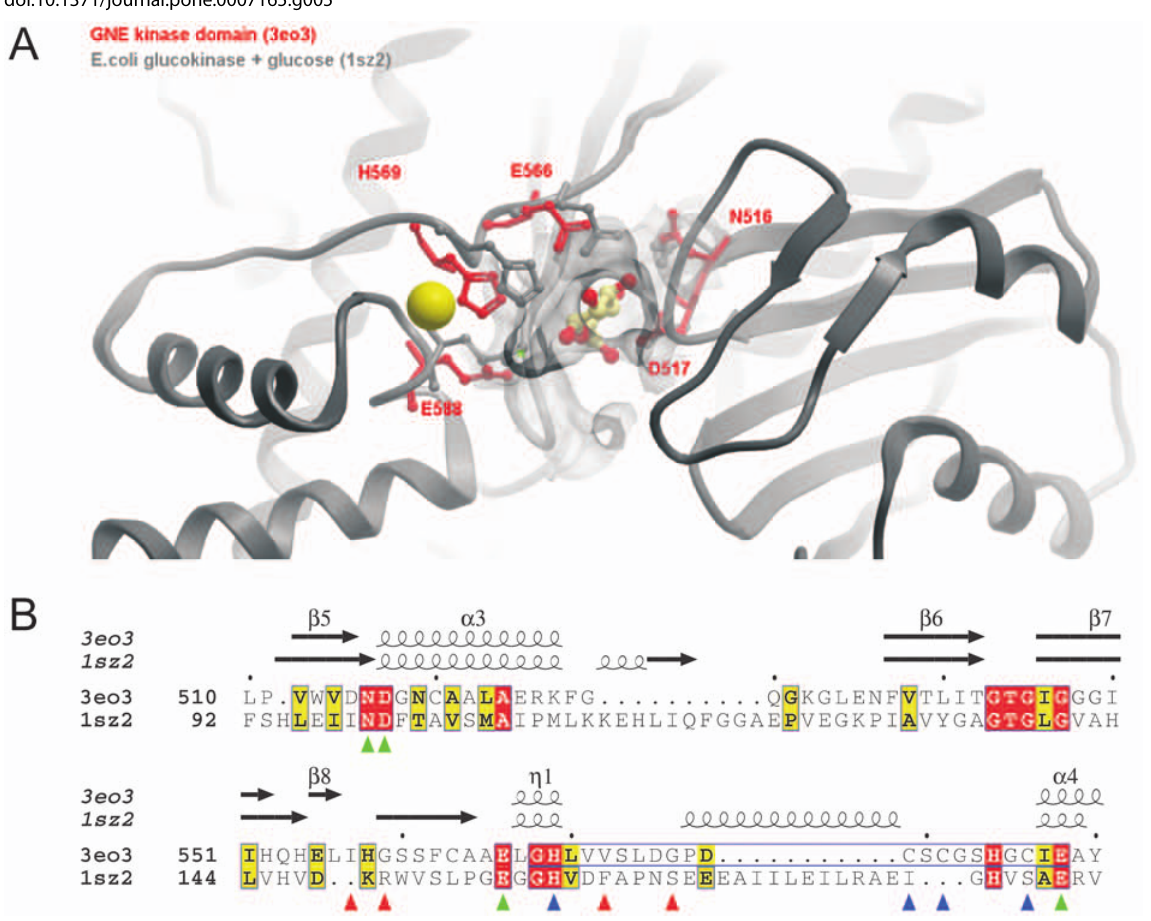
Figure 6. Putative sugar binding residues in the GNE kinase domain. Panel A: structural alignment of GNE kinase (red, 3eo3, only key residues putatively involved in sugar binding are shown as sticks) with E. coli glucokinase + glucose complex (grey, PDB 1sz2). Panel B: Structure- based alignment of the two proteins, only the segment involved in sugar binding is shown. The key residues are marked using green triangles. Residues involved in zinc-binding are marked using blue triangles. HIBM-related mutation sites are marked using red triangles.